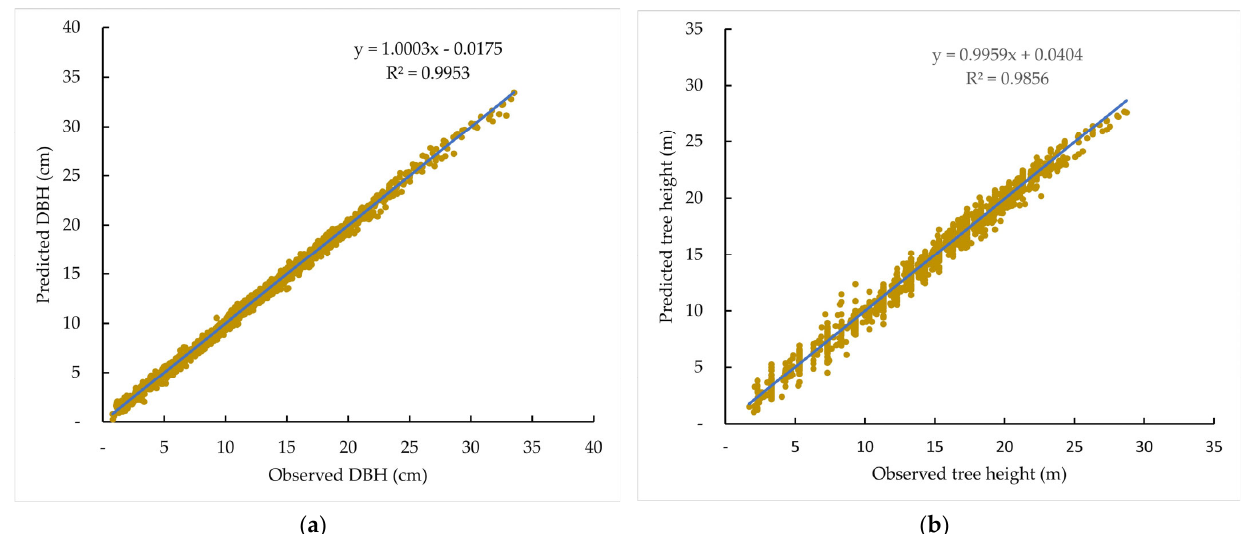
Figure 5. Predicted tree size using Richards growth function; relationship between predicted DBH and observed DBH ( a ), between predicted tree height and observed tree height ( b ). R 2 is the correlation coefficient.